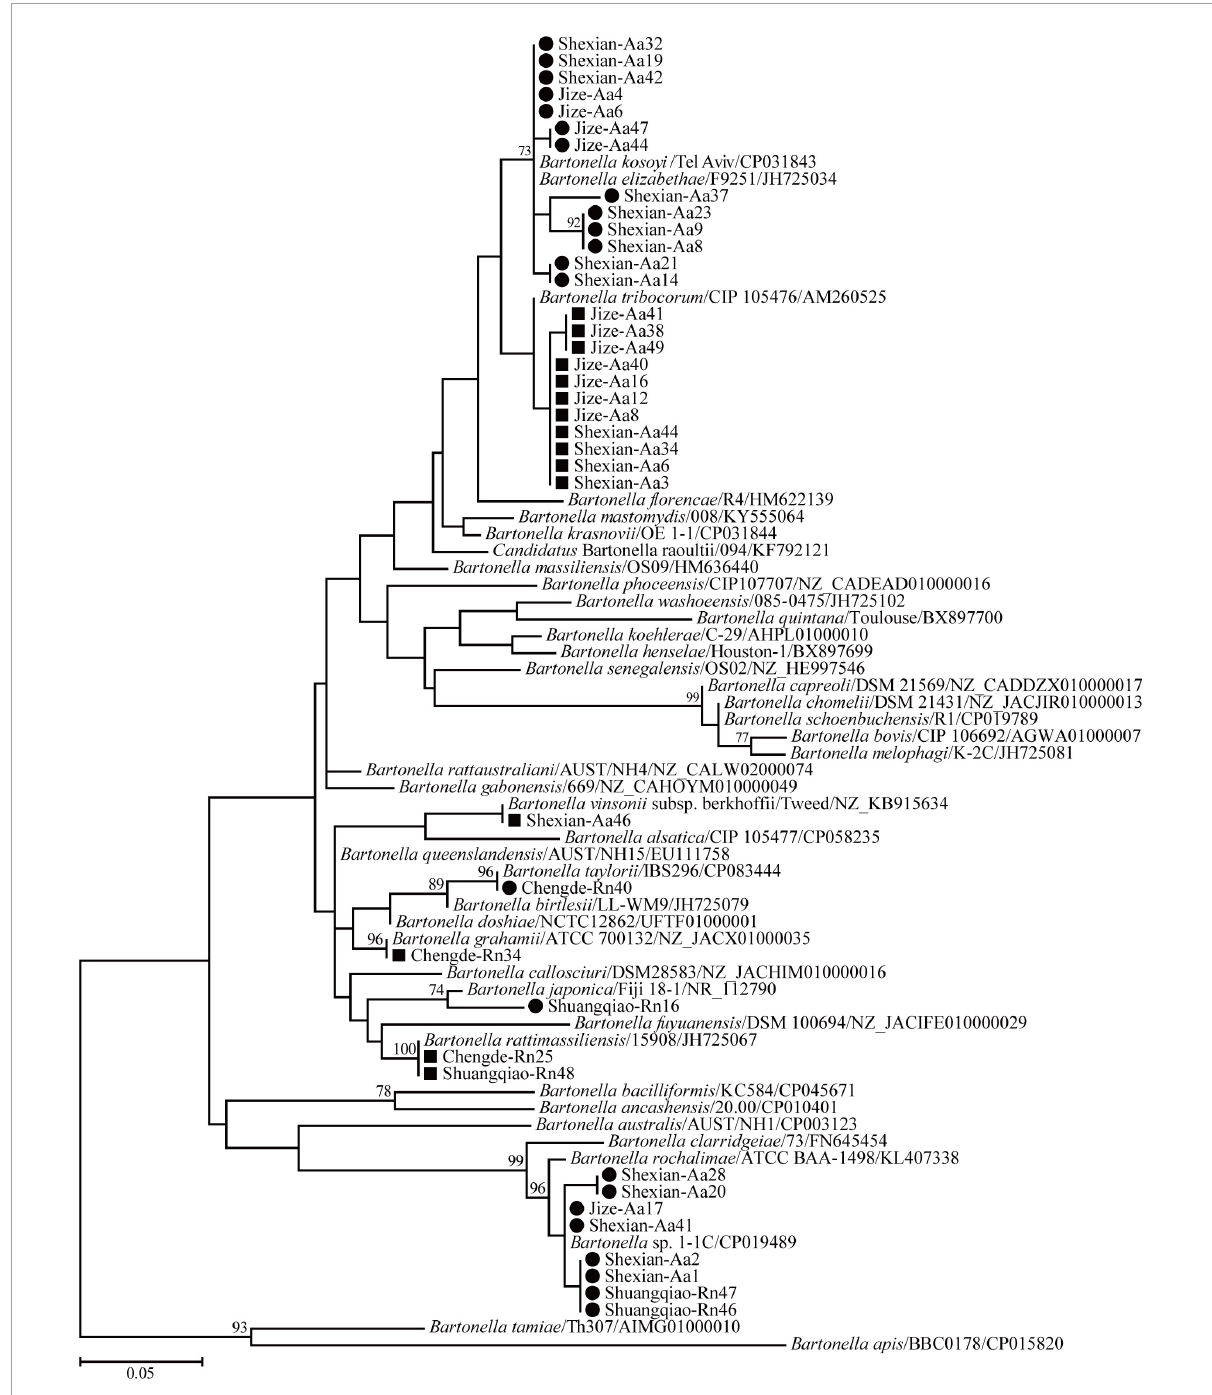
FIGURE2 Maximum-likelihood (ML) tree reconstructed based on the 16S rRNA gene sequences of Bartonella species. Bootstrap values were calculated with 100 replicates and only > 70% are shown. Sequences of human-pathogenic Bartonella species determined herein are marked as black squares and others as black